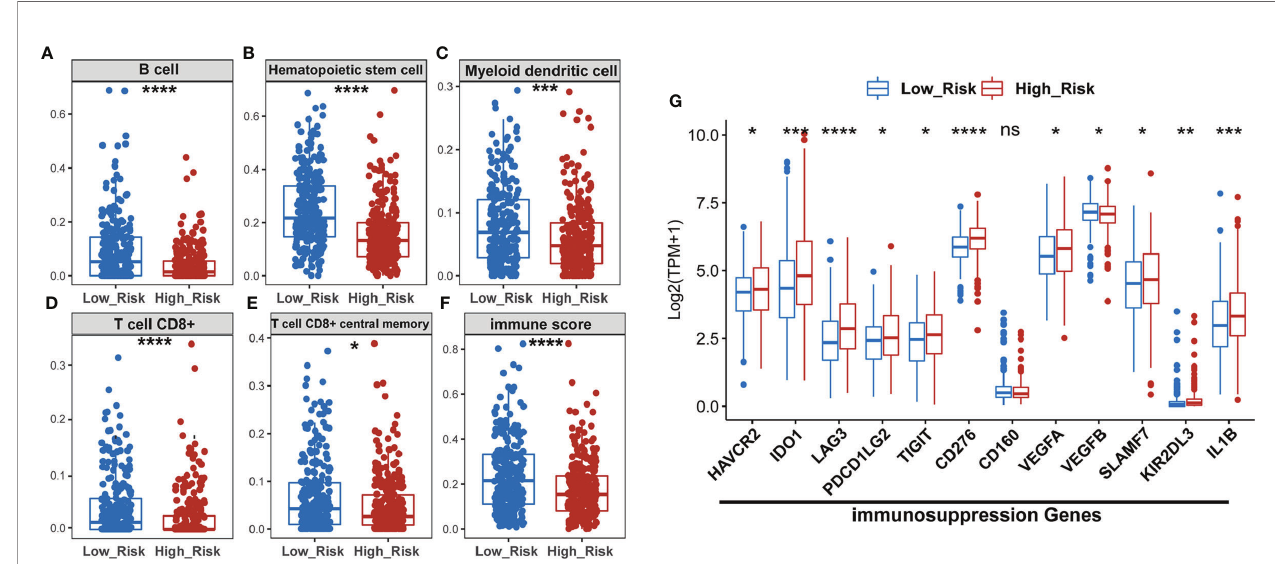
FIGURE 5 | The high-risk LUAD group exhibits relatively lower in fi ltration of B, HSC, MDC, CD8 + T, and memory T cells, and lower immune scores than the low- risk group, but has higher expression of immuno-suppression genes. (A – F) Comparison of in fi ltrating immune cells (xCell) between low- and high-risk groups using